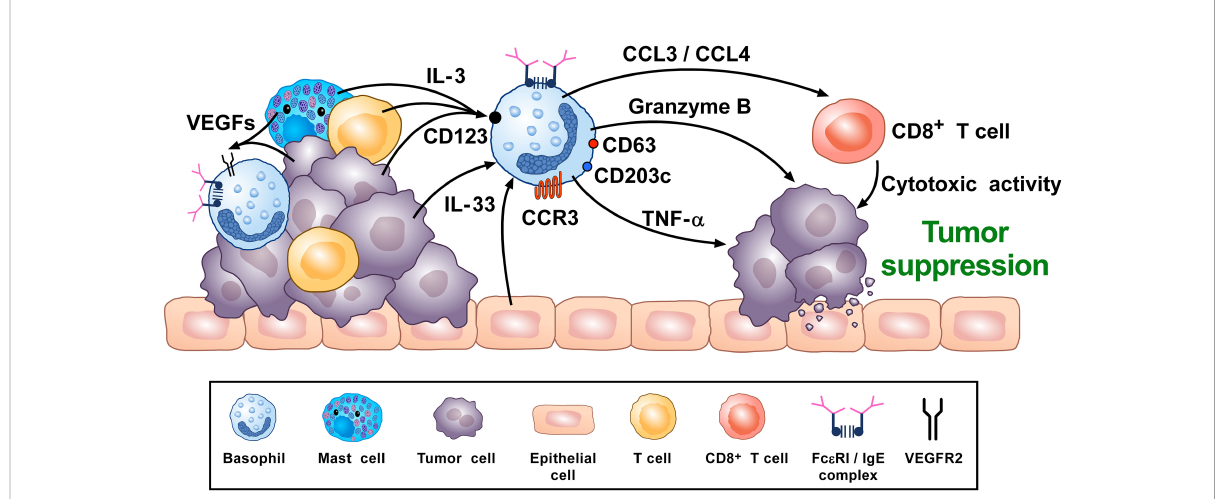
FIGURE 2 Theoretical representation of how basophils can promote tumor suppression. Basophils have been located in the immune in fi ltrate of several human (80, 102, 261, 262) and experimental tumors (80, 97, 102, 276). Vascular endothelial growth factors released by cancer cells and immune cells in tumor microenvironment (TME) (e.g., mast cells, macrophages) (118, 120 – 123) can favor basophil in fi ltration in TME through the engagement of VEGFR2 on these cells (120). IL-3, produced by intratumoral lymphocytes, mast cells and cancer cells (17, 82, 281), is the most important growth and activating factor for human and mouse basophils, through the engagement of the IL-3 receptor (IL-3R a /CD123) (17). CCL3/CCL4 secreted by intratumoral basophils induces CD8 + T cell recruitment in TME, promoting melanoma rejection in mice (270). IL-33, a pleiotropic cytokine produced by epithelial and tumor cells (282), plays a central role in tumorigenesis (282). IL-33 upregulates granzyme B mRNA and the surface expression of CD63, suggesting functional and phenotypic basophil activation. IL-33-activated mouse basophils induce melanoma cell death in vitro (67). Mouse (47, 86) and, under speci fi c circumstances, human basophils (88, 89) release TNF- a . Human and mouse basophils release granzyme B (66, 67). Both TNF- a and granzyme B exert cytotoxic effects on tumor cells (68, 69). Activated signature (CD123, CCR3, CD63, CD203c gene expression) in tumor resident basophils is associated with improved outcome in ovarian cancer patients (248, 261). Topical exposure to a DNA-damaging carcinogen promotes tumor-protective IgE response through skin in fi ltrating basophils (276). Taken together, these results suggest that, in certain experimental and clinical conditions, basophils and their mediators may play an anti- tumorigenic